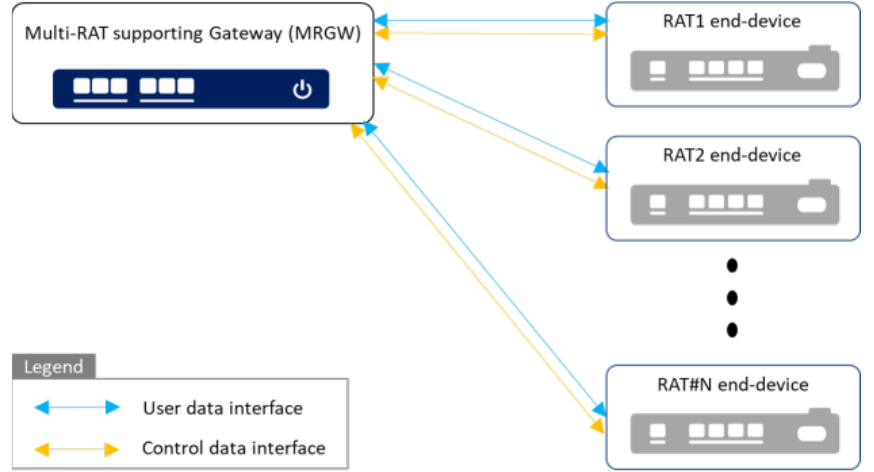
Figure 4. Interfaces between the MRGW and each RAT end-device.